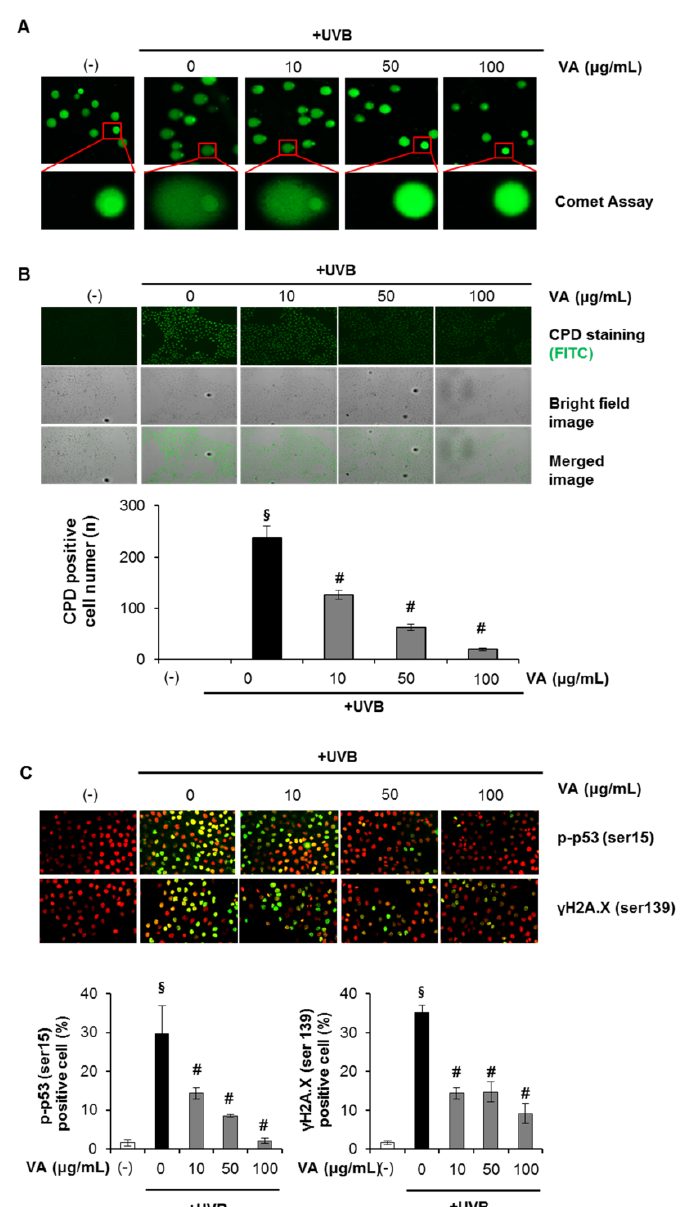
Figure 3. Effect of veratric acid on UVB-induced DNA damage. ( A ) Analysis of DNA damage by the comet assay. ( B ) Cyclobutane pyrimidine dimer (CPD) quantification. ( C ) Immunofluorescence analysis of phophoactive histone H2A.X ( γ H2A.X) and phospho- p53